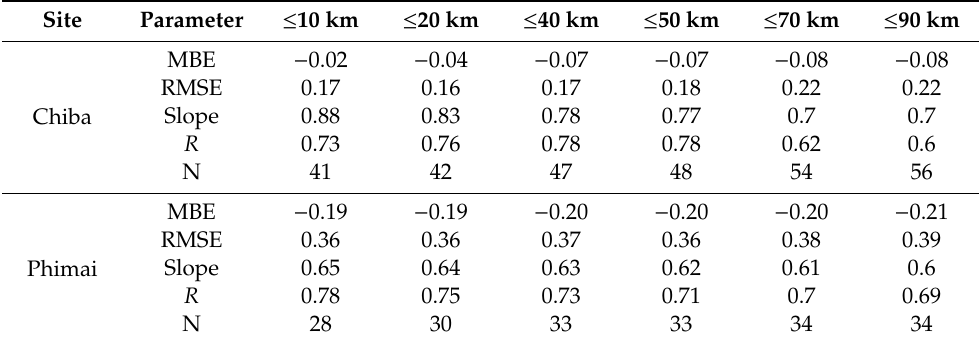
Table 9. The MBE, RMSE, slope, and R calculated for the di ff erent spatial resolution of the GCOM-C observations. The parameters were calculated for both wavelengths in Chiba and Phimai. The number of data points (N) for each coincidence criterion for both sites is also